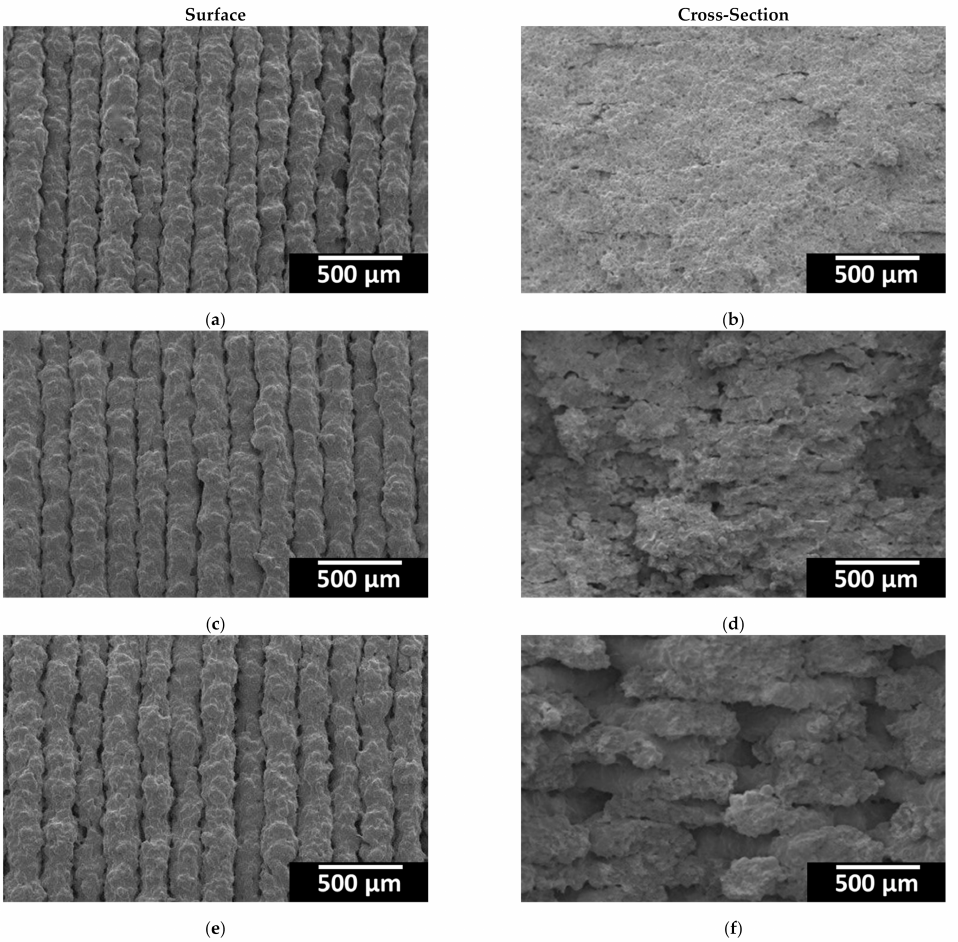
Figure 5. Surface and cross-sectional SEM images of printed samples at different speeds